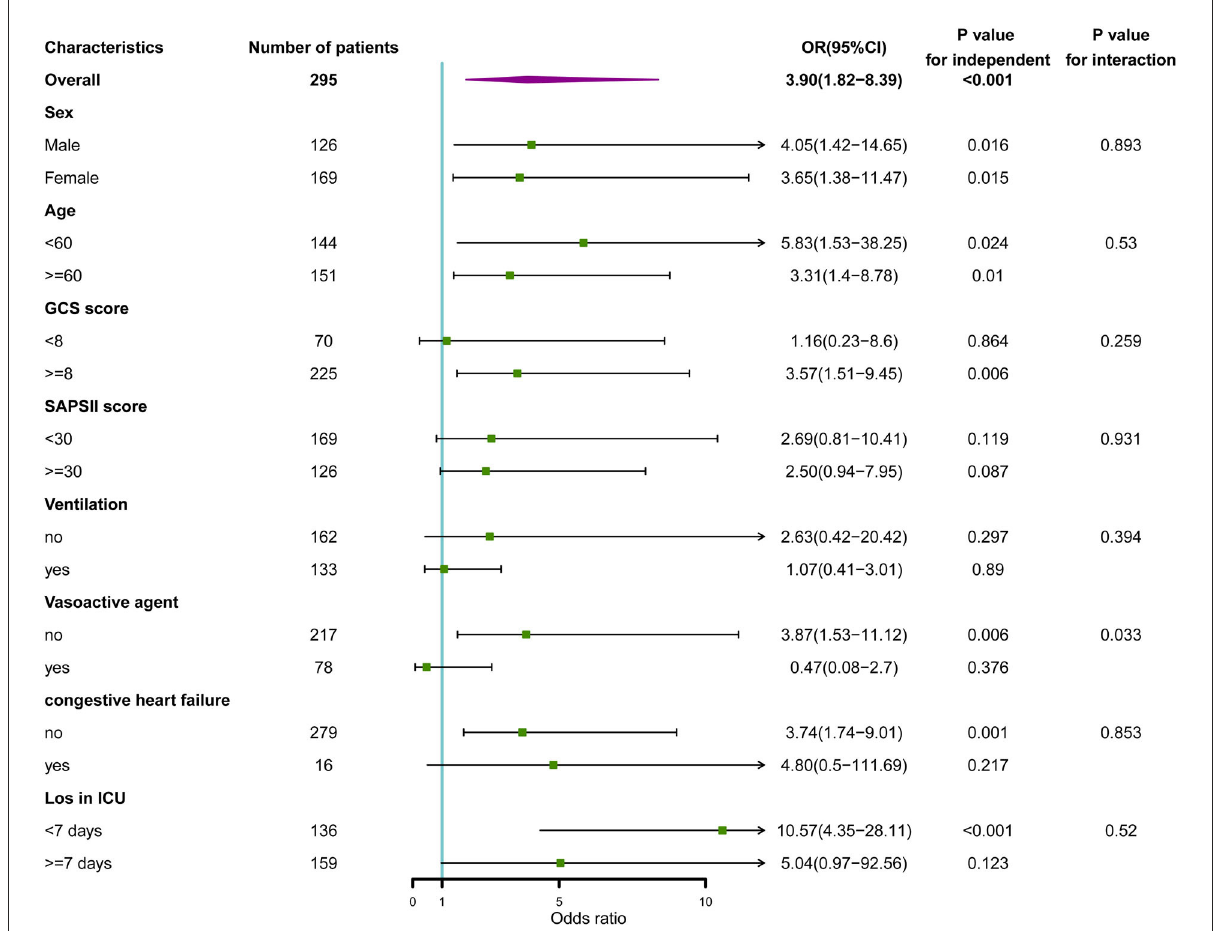
FIGURE5 Subgroup analysis of the association between serum sodium and in-hospital mortality. Horizontal lines represent 95% confidence intervals. OR, odds ratio.